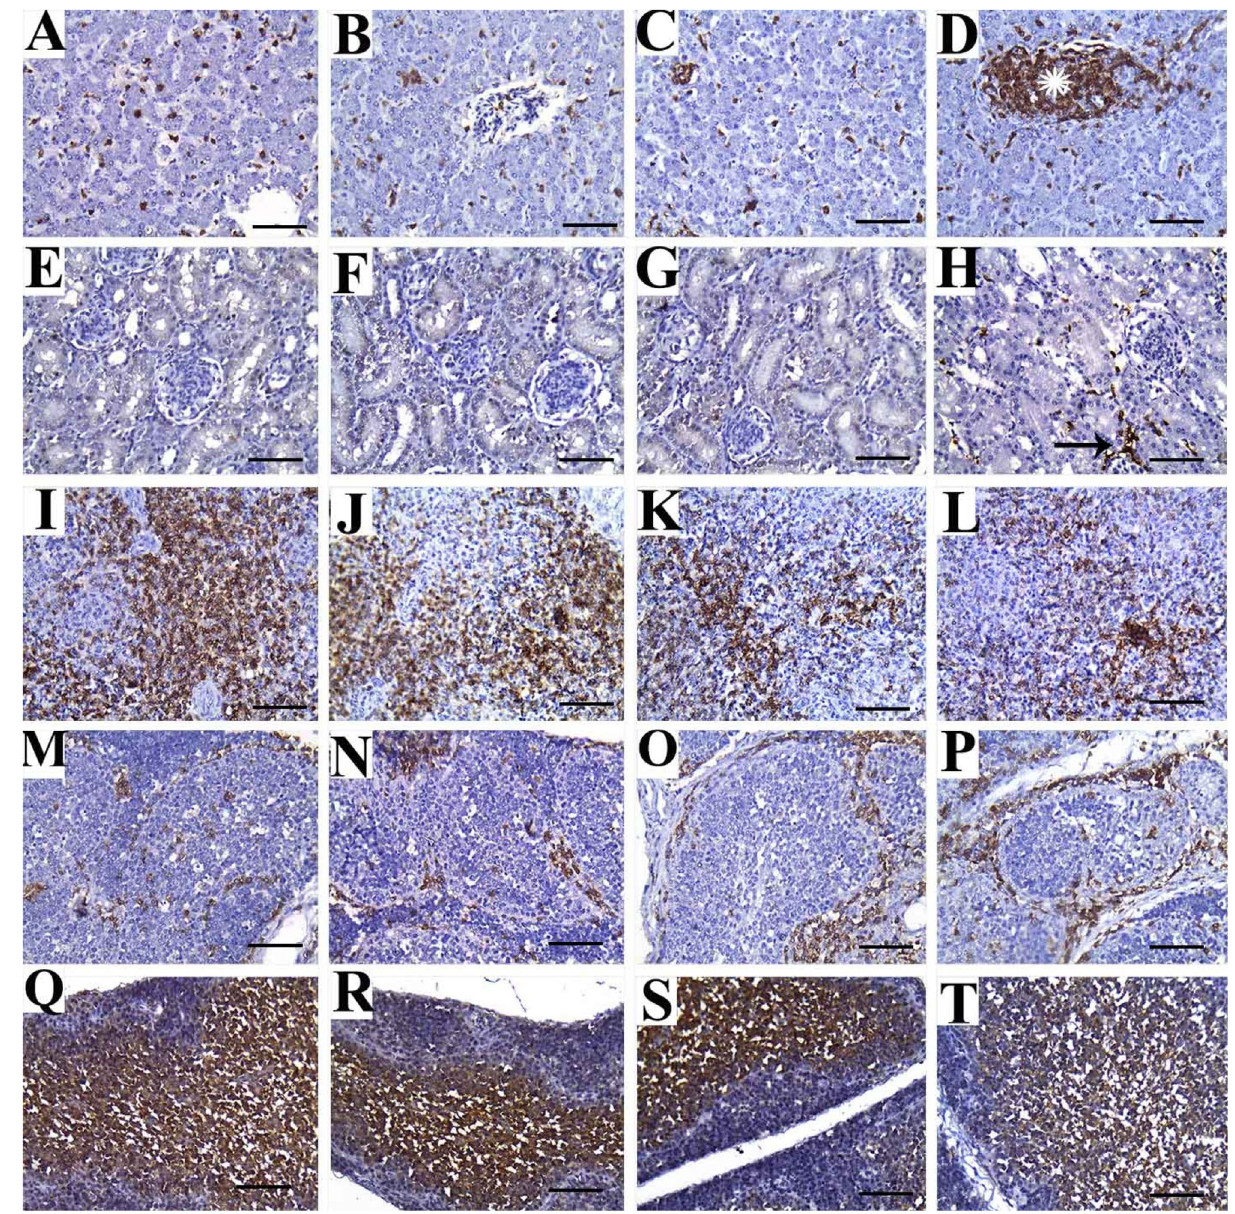
Figure 4. Representative photomicrographs for liver ( A – D ), kidney ( E – H ), spleen ( I – L ), bursa of Fabricius ( M – P ) and thymus ( Q – T ) of broiler chickens treated with different levels of SiO 2 @AgNPs for 35 days; CD45 immunostaining; bar = 50 μm. Chickens from control group ( A , E , I , M , Q ); chicken treated with 2 mg of SiO 2 @ AgNPs ( B , F , J , N , R ); chicken treated with 4 mg of SiO 2 @AgNPs ( C , G , K , O , S ); chicken treated with 8 mg of SiO 2 @AgNPs ( D , H , L , P , T ) showed: positive immune expression in form of frequent individual infiltration of leukocytes between hepatocytes ( A – C ); multifocal areas of aggregated leukocytes (asterisk) ( D ); negative immune expression against CD45 ( E – G ); infrequent interlobular positively stained leukocytes (arrow) ( H ); marked immunoexpression of CD45 at the periarterial lymphoid sheath (PALS) ( I , J ); mild to moderate CD45 immunoexpression within PALS ( K , L ); mild to moderate immunoexpression of CD45 in the interfollicular areas ( M , N ); marked CD45 expression within the inflamed widened interfollicular spaces ( O , P ); positive immune staining of CD45 in medullary thymocytes ( Q – S ); reduced intensity of immune expression in medullary thymocytes ( T